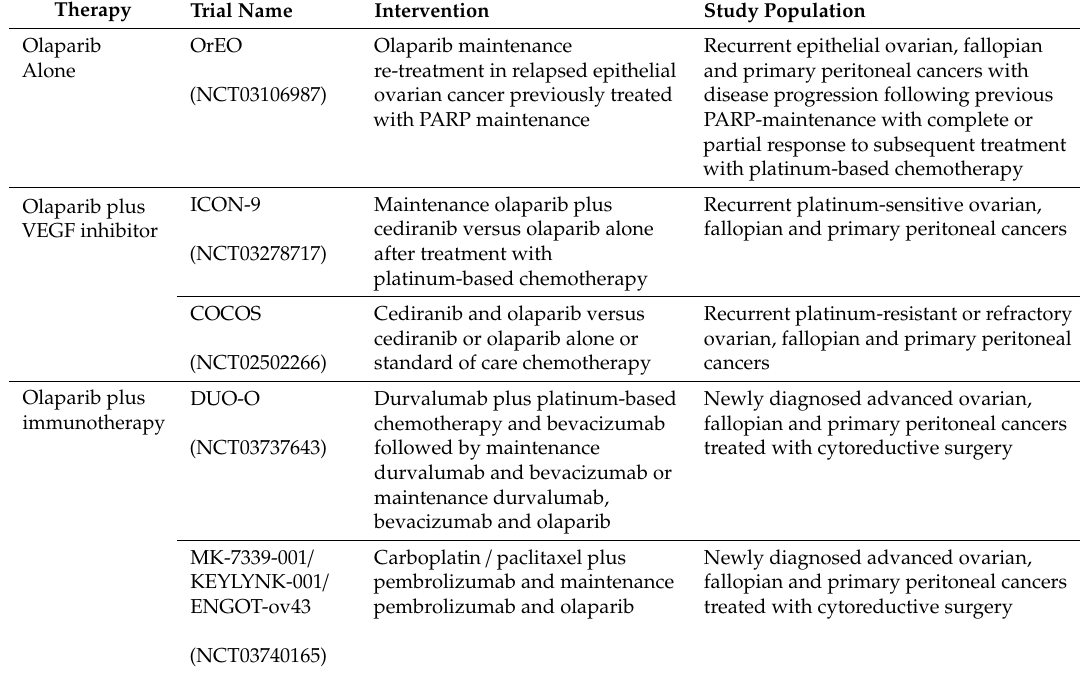
Table 2. Ongoing phase 3 trials of olaparib monotherapy or combination